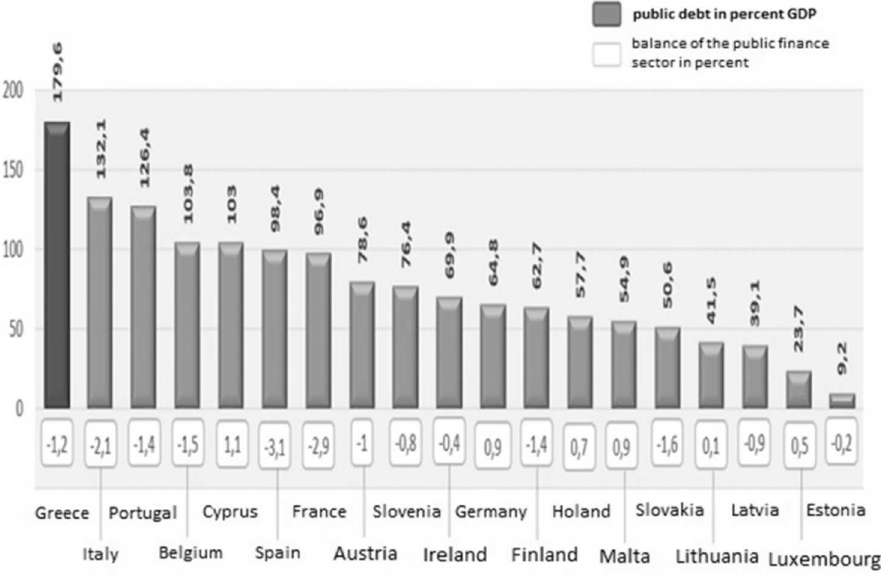
Source: European Commission. Data from November